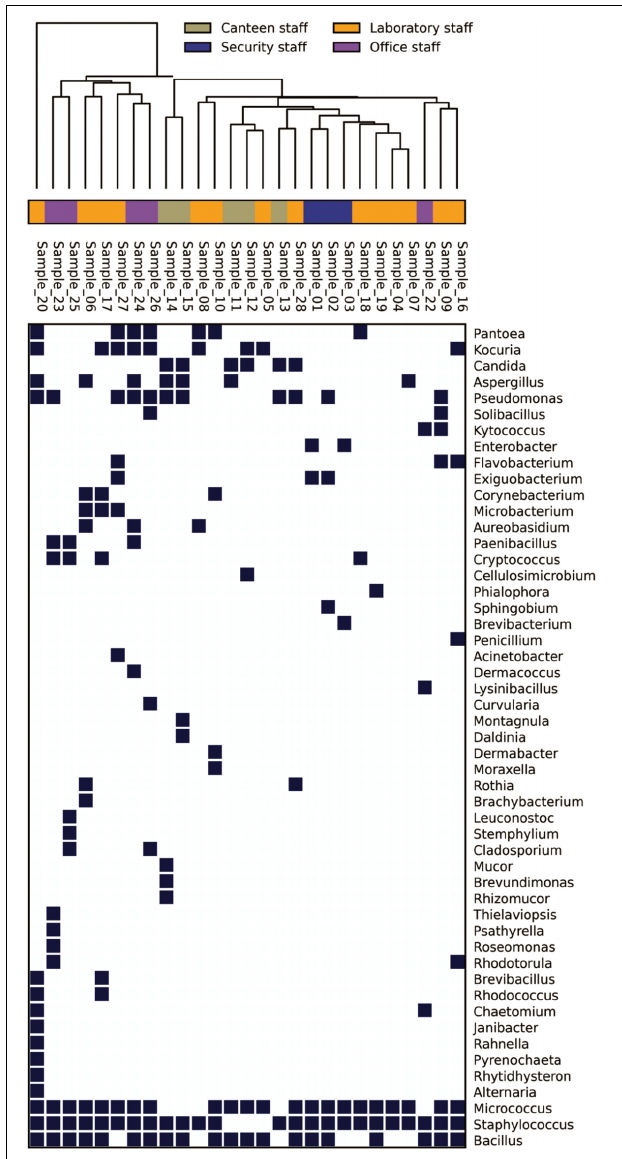
FIGURE 3 | Genus-level distribution of microbial communities isolated from the samples collected of cellular